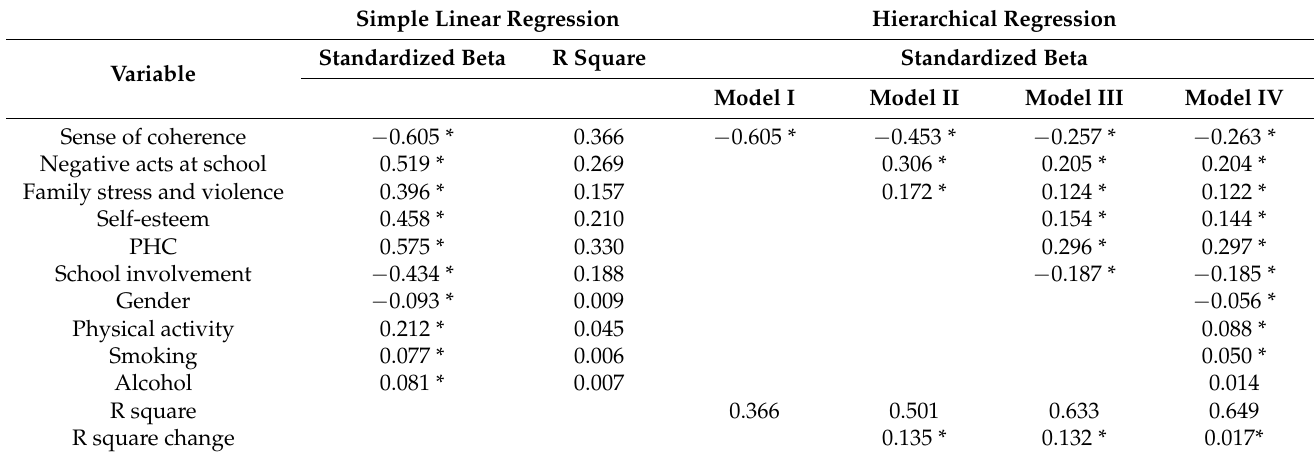
Table 2. Predictors of depressive symptoms among adolescents (simple and hierarchical linear regression analysis). Simple Linear Regression Hierarchical